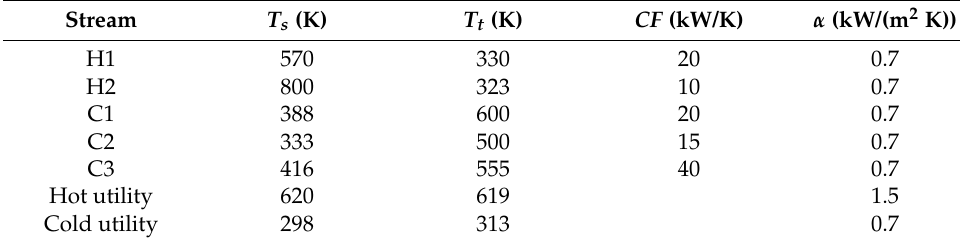
Table 8. Data for HEN synthesis.